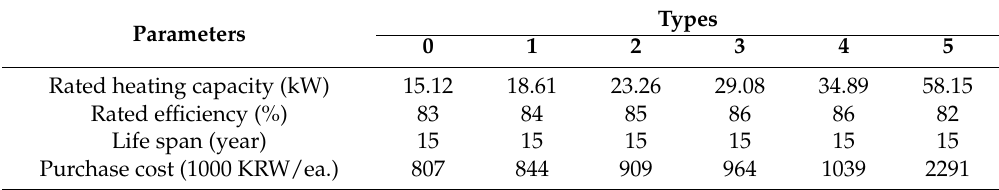
Table A4. Technical and economic parameters of auxiliary heaters for case